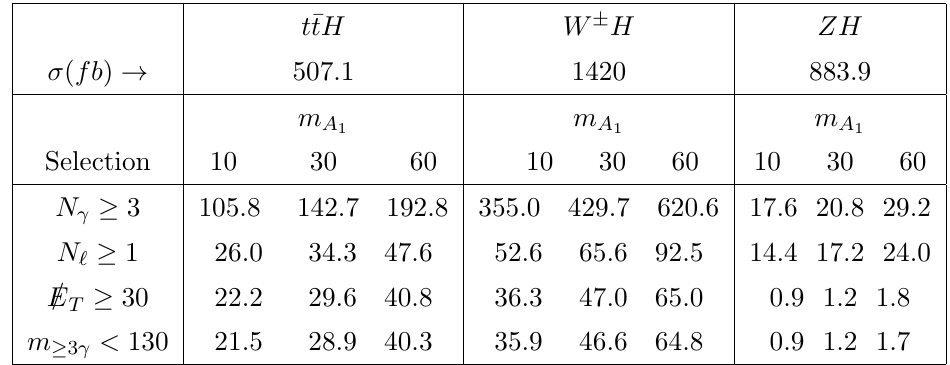
Table 3 . Cross sections ( (cid:27) ) after each set of cuts normalizing it by acceptance e(cid:14)ciencies for three values of m A (in GeV). 1